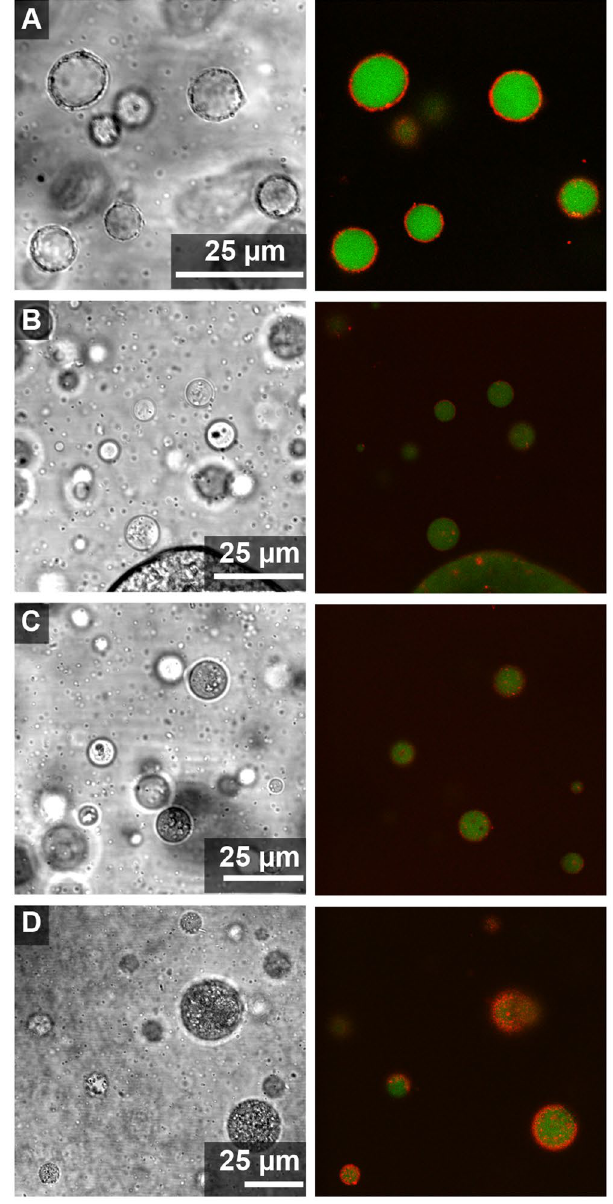
Figure 6. Clay distribution in ATPS having reverse volume ratio. For 20%/20% w/w PEG 8 kDa-Dx 10 kDa using volume ratio of 1:20 PEG-rich phase: Dx-rich phase with ( A ) Kaolinite (KGa-2), ( B ) Na-rich montmorillonite (SWy-2), ( C ) Ca-rich montmorillonite (STx-1b) and ( D ) NX-illite. Labeled Dx (red, 2 μ M final concentration) and labeled PEG (green, 2 μ M final concentration) have been used for fluorescence imaging. Left-hand images show transmitted light, and right-hand images show overlay of red and green confocal fluorescence channels. Continuous phase is Dx-rich phase while droplets are PEG-rich